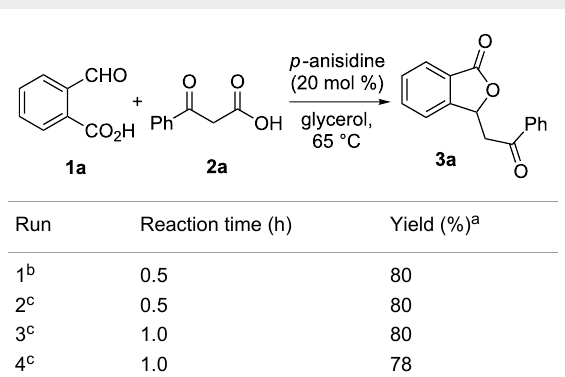
Table 2: Reuse of glycerol in the synthesis of 3a